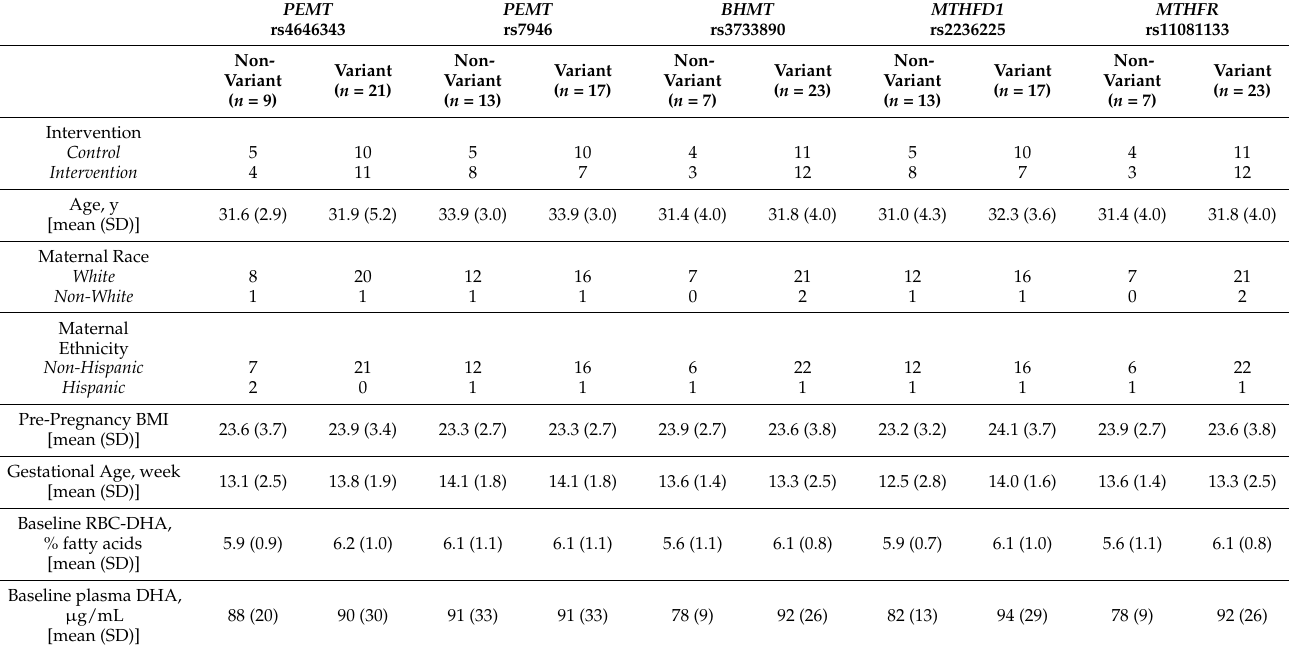
Table 2. Maternal clinical and demographic characteristics by maternal genotype 1